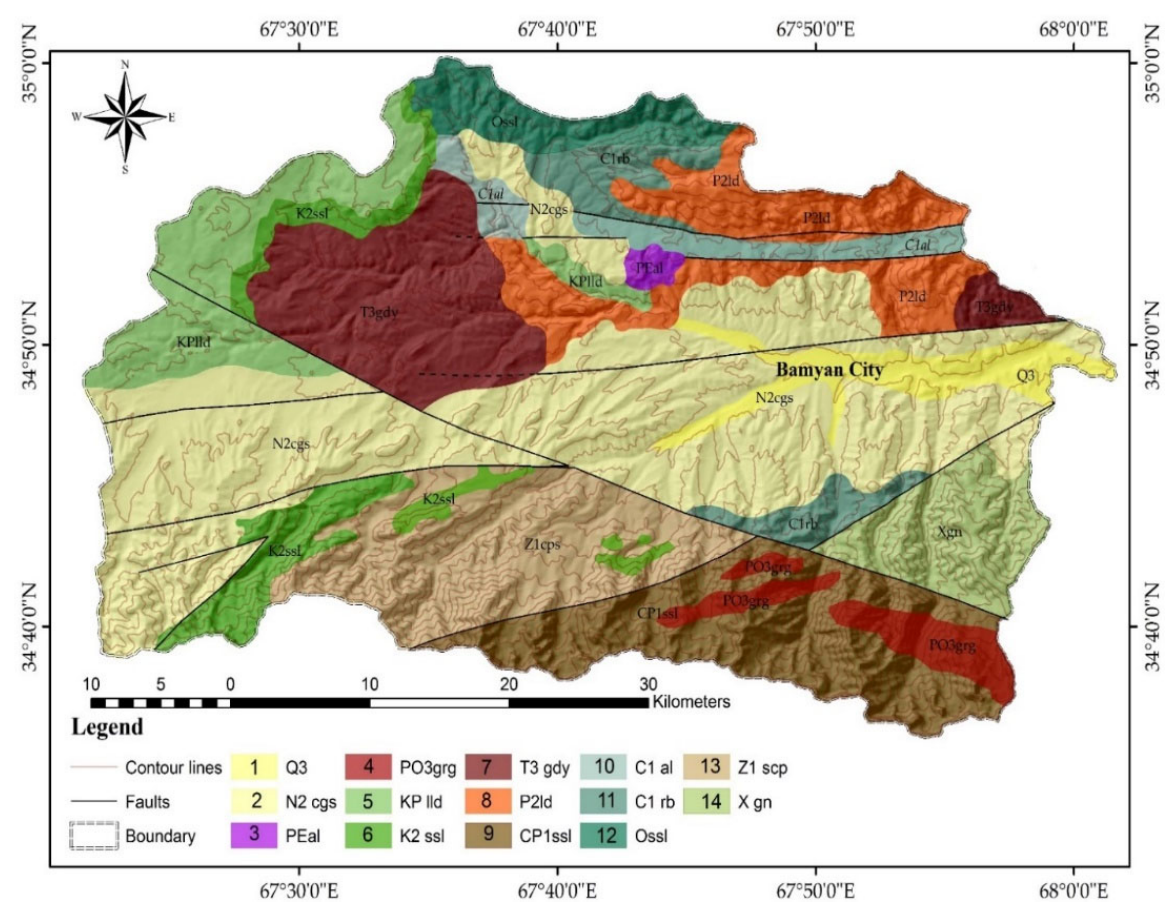
Figure 3 . Geologic map of the study area. 1. Quaternary, alluvium, mostly gravel, sand, and silt. 2. Neogene, mostly conglomerate, sandstone and siltstone. 3. Eocene, andesite lava. 4. Paleocene ‐ Oli ‐ gocene, granite and granodiorite. 5. Cretaceous ‐ Paleocene, limestone and dolomite. 6. Late Creta ‐ ceous, sandstone and siltstone. 7. Late Triassic, granite and granodiorite. 8. Late Permian, limestone and dolomite. 9. Carboniferous ‐ Permian, sandstone and siltstone. 10. Early Carboniferous, andesitic volcanic. 11. Early Carboniferous, basaltic volcanic. 12. Ordovician, shale, siltstone, and schist. 13. Neoproterozoic, schist, slate, and phyllite. 14. Paleoproterozoic, gneiss (modified from [38]).